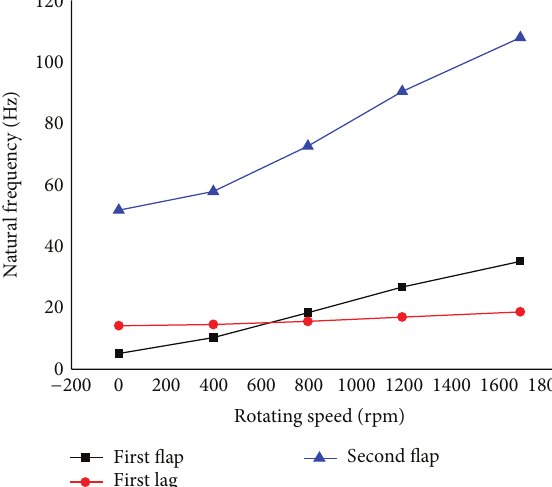
Figure 7: The relationships between modal frequencies and rotational speed by the large deflection beam